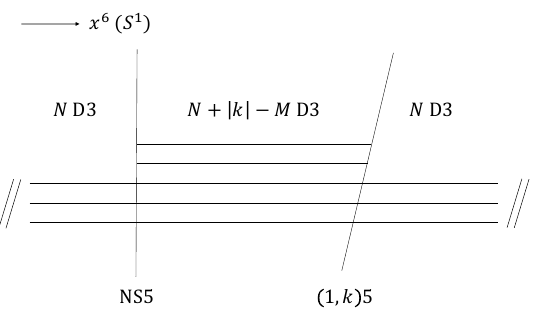
U( N + M ) theory with | k | ≥ M . ( N = 3 , k × − k